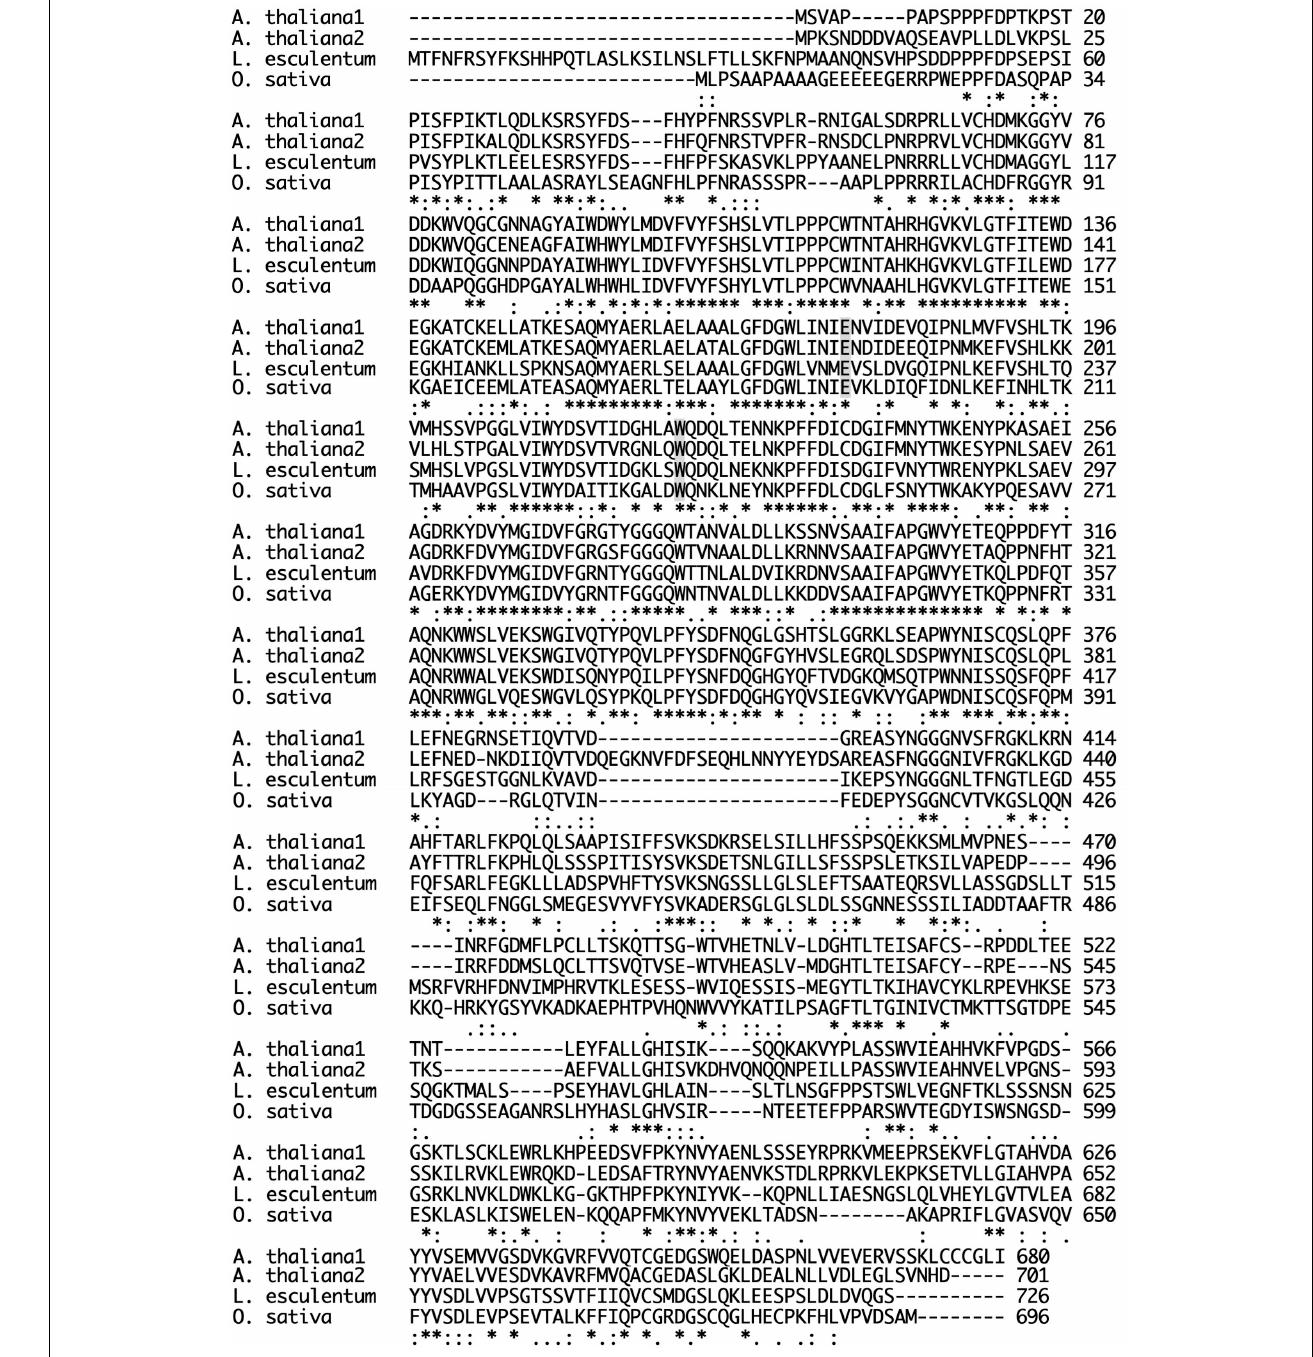
FIGURE 8 | Comparison of sequences of plant Endo- β -GlcNAc-ase. Endo-AT1 and -AT2, Arabidopsis thaliana endo- β -GlcNAc-ase (F4JZC2 and Q9SRL4); Endo-LE, Lycopersicum esculentum endo- β -GlcNAc-ase (A0A3Q7HNF7); Endo-Os, Oryza sativa putative endo- β -GlcNAc-ase (Endo-Os, Q5W6R1). A gray box indicates an important site; E, endo- β -GlcNAc-ase; W, transglycosylation.